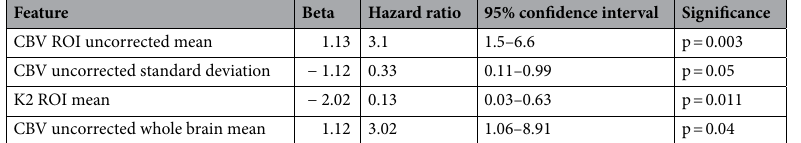
Table 1. Cox regression results.